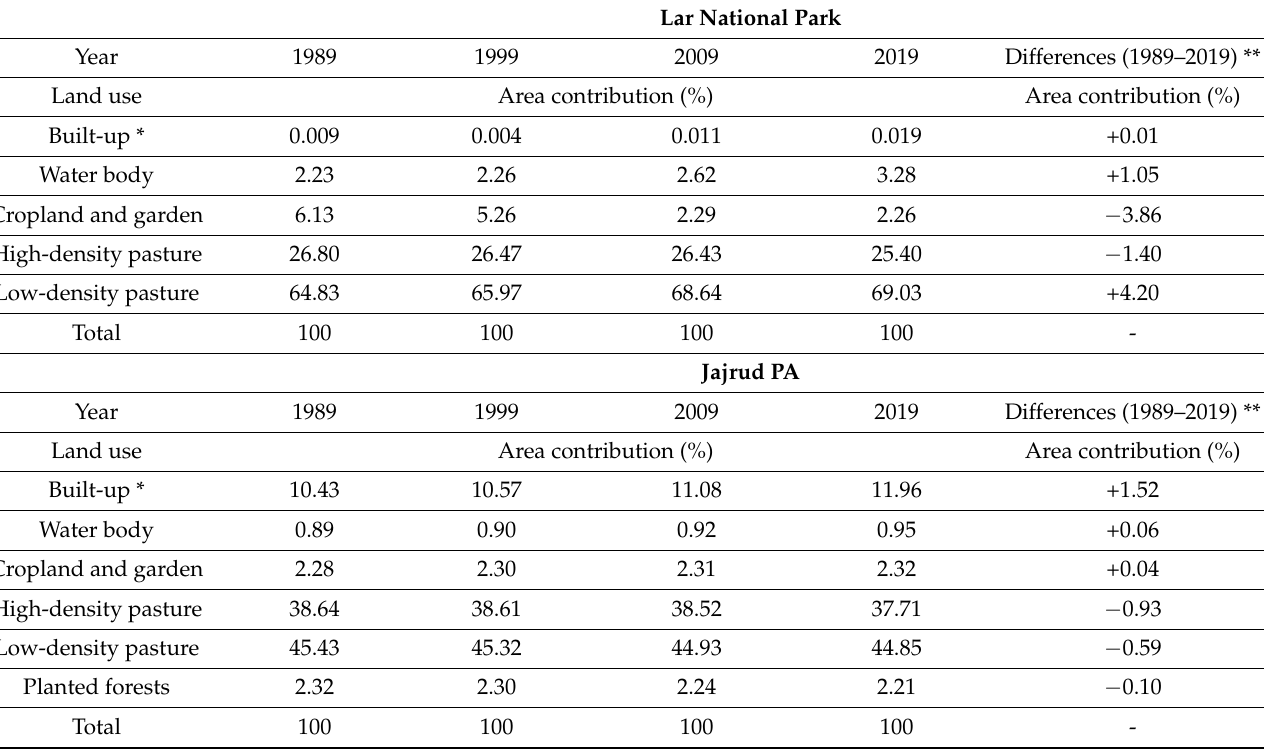
Table 4. Changes in LULC classes between 1989 and 2019 in three